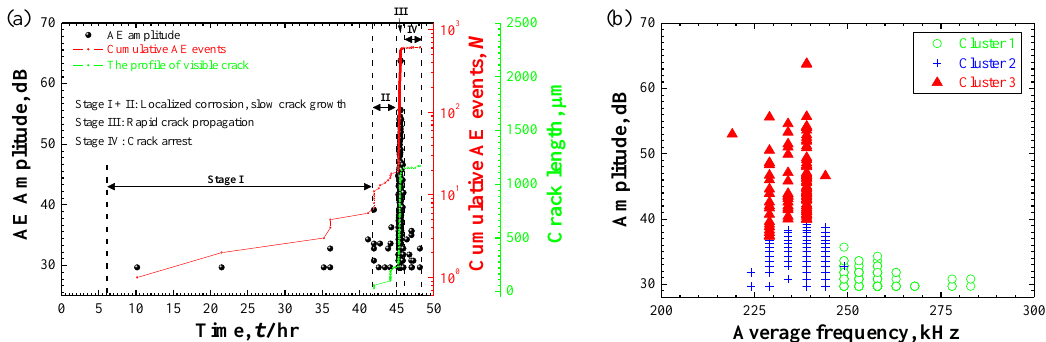
Figure 13. ( a ) The AE activity of amplitude and cumulative AE events and the profile of visible crack over time evolution and ( b ) the result of clustering analysis showing three AE clusters with different AE features during SCC evolution in specimen B. Online version in color.